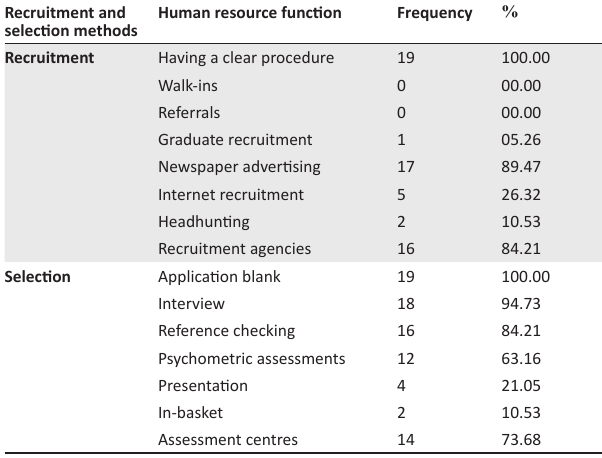
TABLE 3: Recruitment and selection methods in